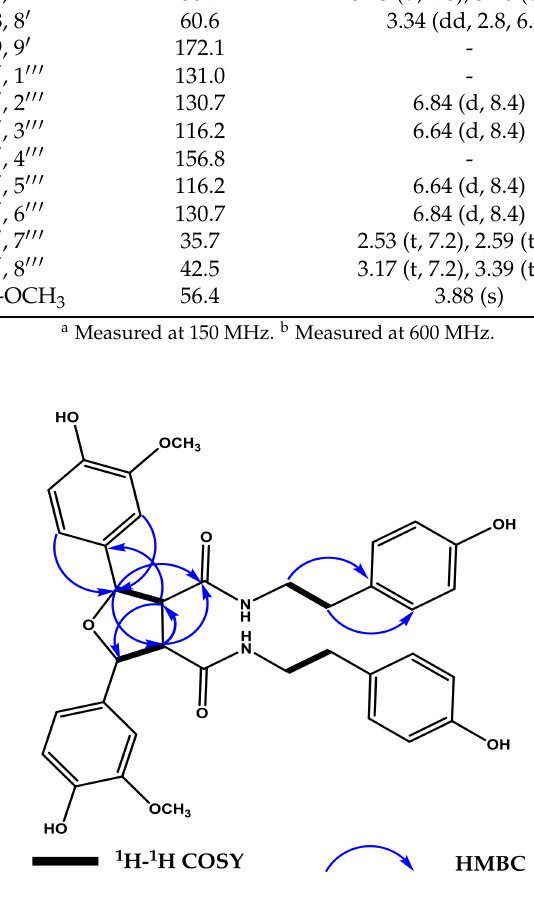
Figure 2. Key 1 H– 1 H COSY and HMBC correlations for compound 1